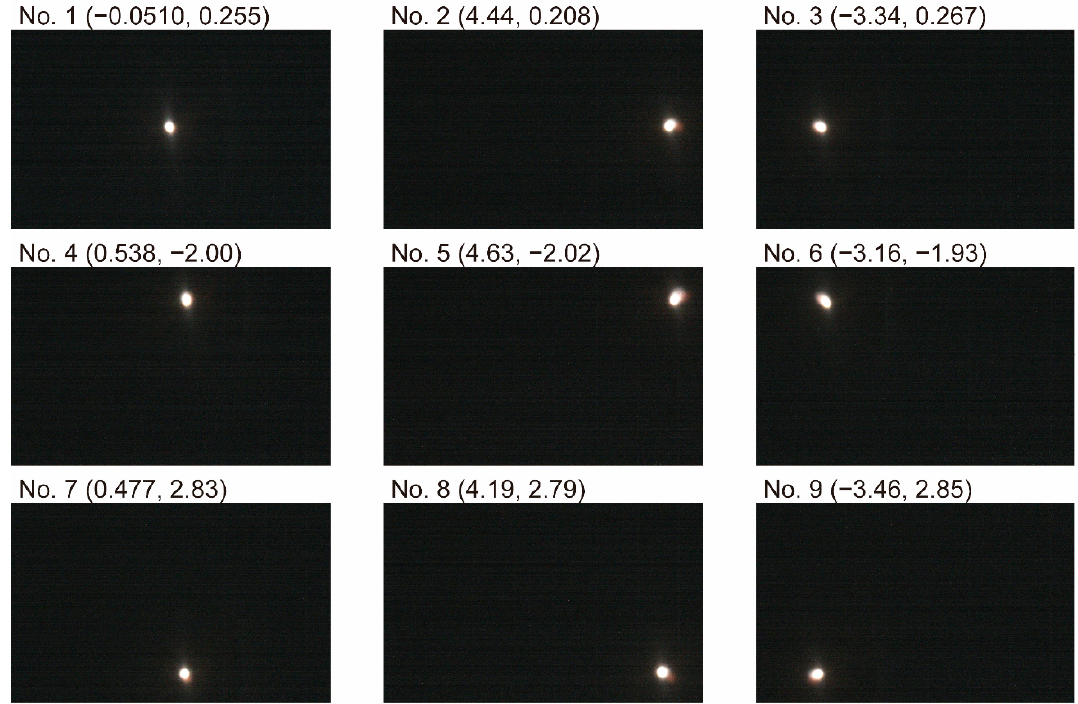
Figure A2. Captured color images of the light source at 0.5 m from the hybrid lens.